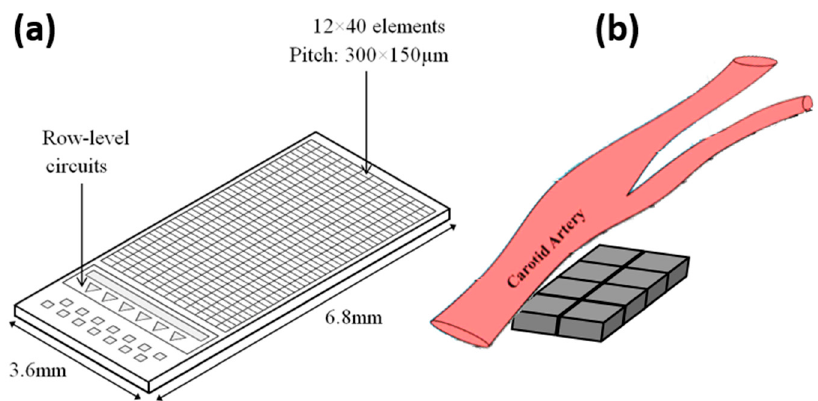
Figure 1. ( a ) Schematic of a single tile consisting of 12 × 40 acoustic elements on top of an Application Specific Integrated Circuit (ASIC) with element-level switches and row-level circuits. ( b ) The proposed transducer consisting of 4 × 2 tiles with respect to the carotid artery (carotid has a diameter of 6–9 mm; the array is 12 × 14 mm).